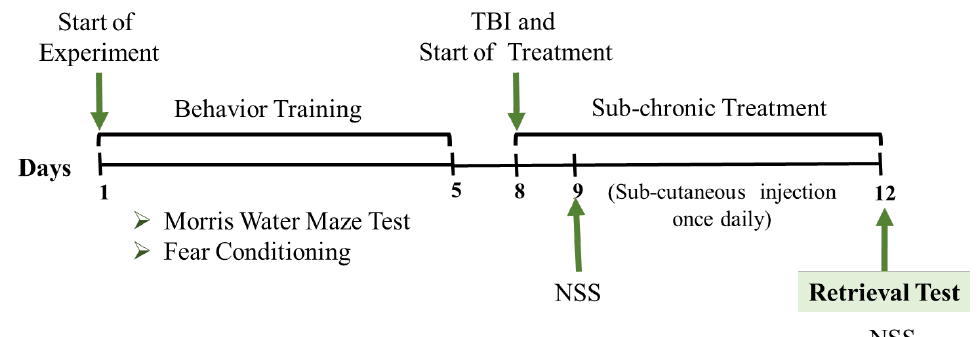
Figure 1. Scheme of the experimental design. TBI was induced after 5 days of behavior training, and memory retrieval was performed on day 12. TBI: traumatic brain injury, NSS: neurological severity scoring.